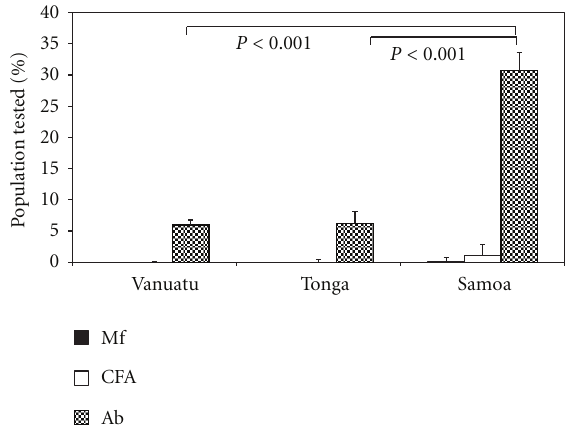
Figure 1: Prevalence rates of the diagnostic parameters: Mf, CFA, and antibody in children. There was a significantly lower antibody (Ab) prevalence in children in Vanuatu and Tonga and a significantly higher antibody prevalence in children in Samoa ( χ 2 = 549 . 3; df = 3; P < 0 . 001). There were no Mf or CFA positive children detected in either Vanuatu or